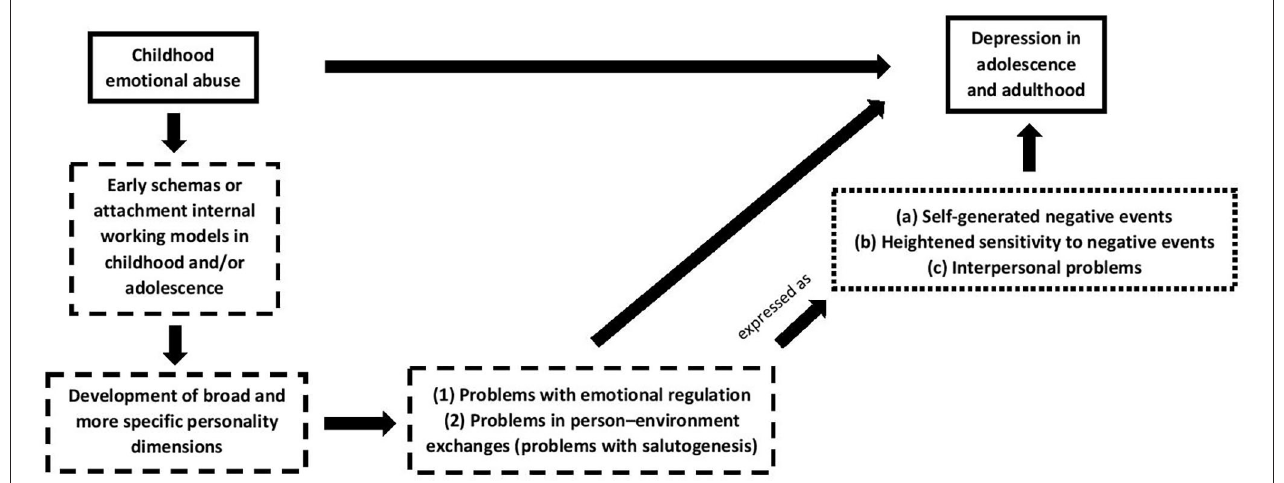
FIGURE 3 | A multilevel integrative model of the relationship between childhood emotional abuse and adult